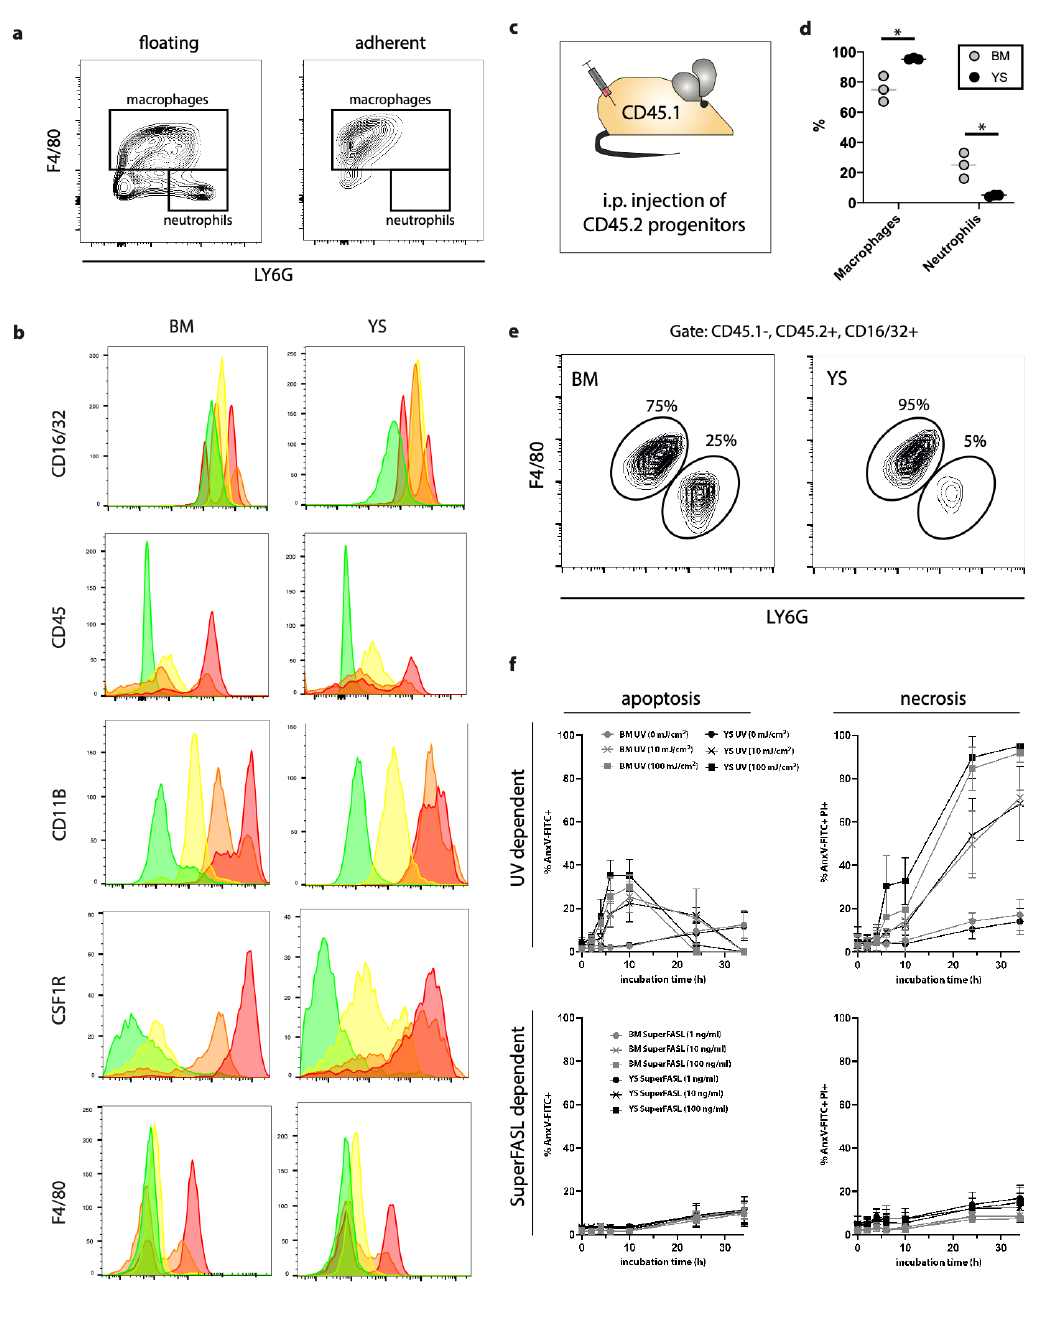
Figure 2. Expression profile and survival of Hoxb8 macrophages. ( a ) Flow cytometry analysis of floating or adherent differentiated (day 5) Hoxb8 BM cells labeled with indicated antibodies (representative plot, n = 3). ( b ) Flow cytometry analyses of Hoxb8 progenitors in the process of differentiation towards macrophages (d0 to d6) labeled with indicated antibodies (representative experiment of n = 3). ( c ) Schematic graph for intraperitoneal Hoxb8 progenitor application. ( d – f ) Flow cytometry quantification of in vivo differentiated Hoxb8 macrophage and neutrophil populations obtained by peritoneal lavage after one week. Live CD45.1 − CD45.2+ CD16/32+ single cells were gated, then macrophages and neutrophils were separated by F4/80 and LY6G intensities. Results are displayed as ( d ) relative quantities of differentiated cell populations; ( e ) corresponding contour plots (representative experiment of n = 3). ( f ) Quantification of UV and SuperFASL dependent apoptosis and necrosis in differentiated Hoxb8 macrophages. n = 3. Unpaired, two-tailed t -test. (*) p <